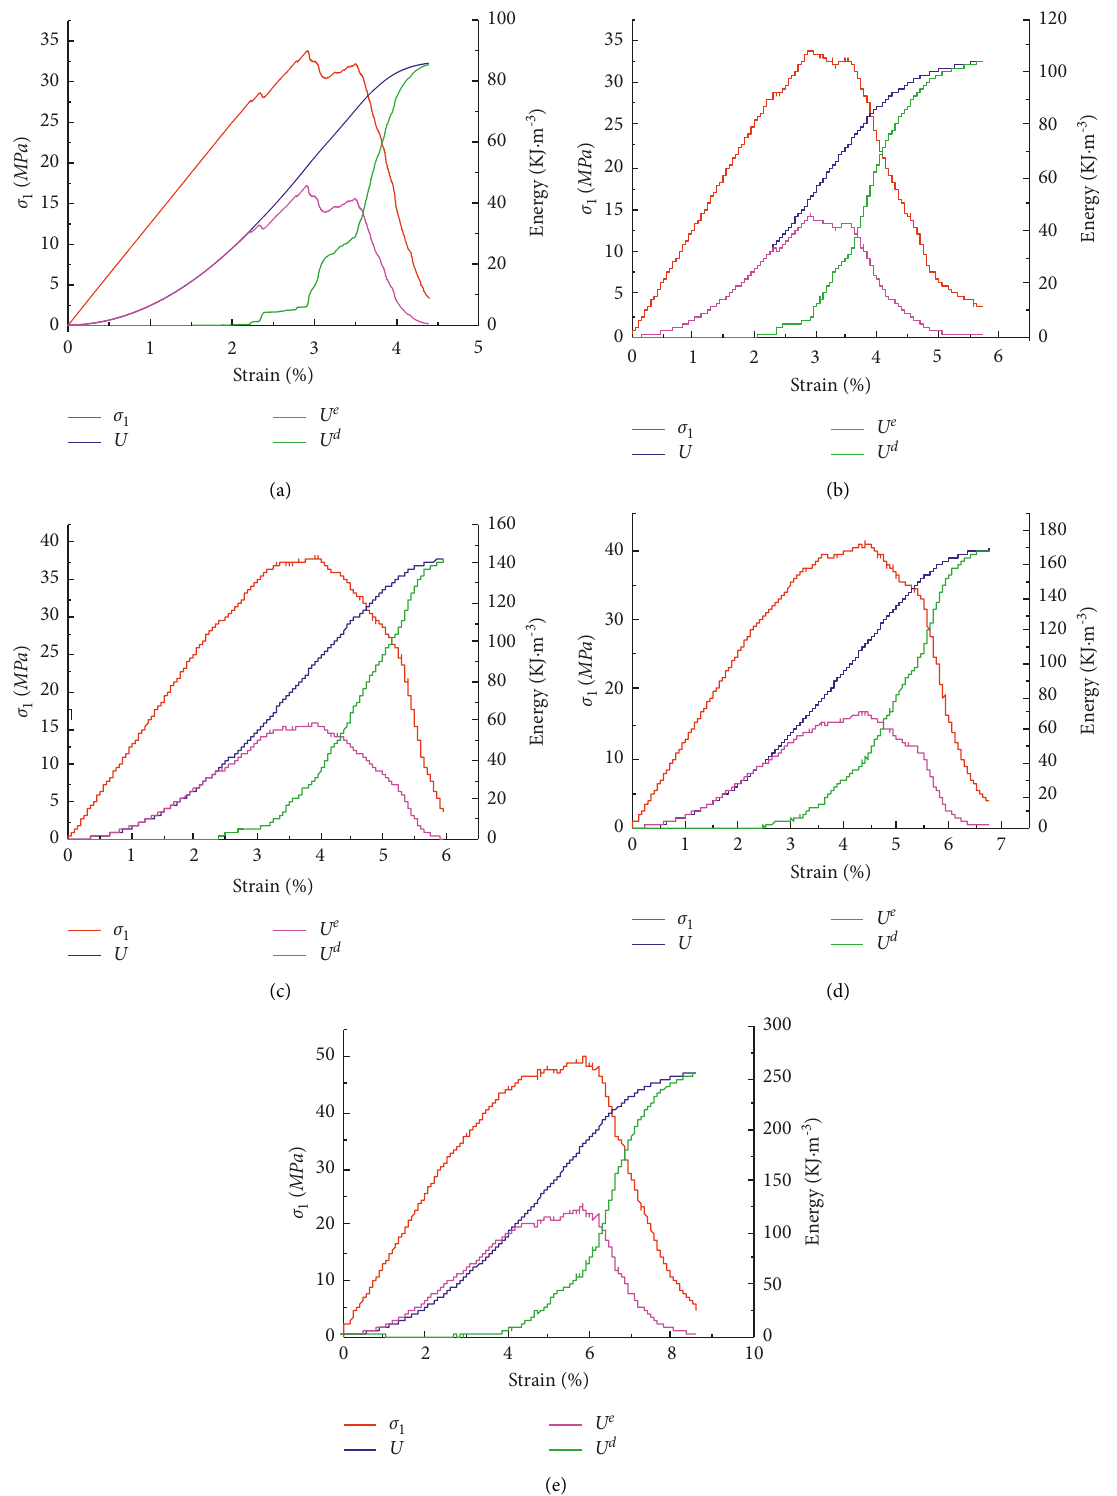
Figure 6: Stress-energy-strain curves under different loading rates. (a) 0.01mm/s. (b) 0.02mm/s. (c) 0.05mm/s. (d) 0.10mm/s. (e)